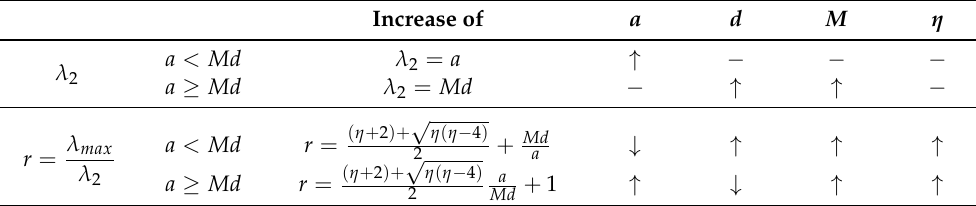
Table 2. Changes of λ 2 , r with a , d , M , η of multilayer Networks-B. Increase of a d M